Question: Write a descriptive caption for this figure.
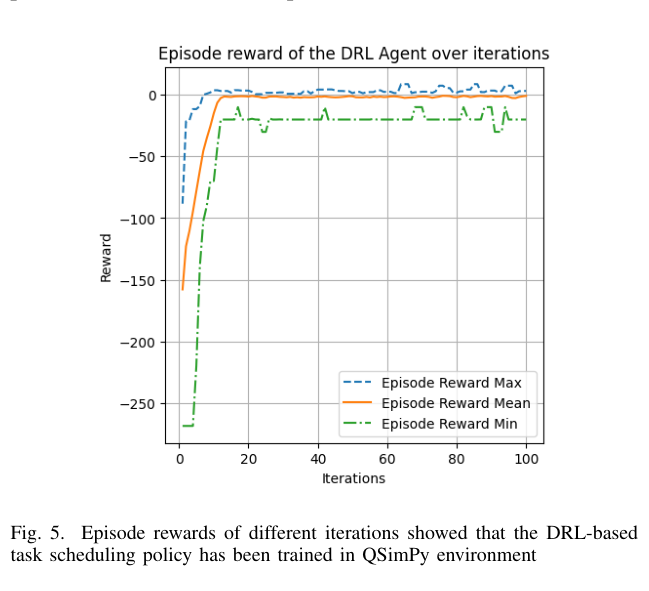
Answer: shows the episode reward values for the 105